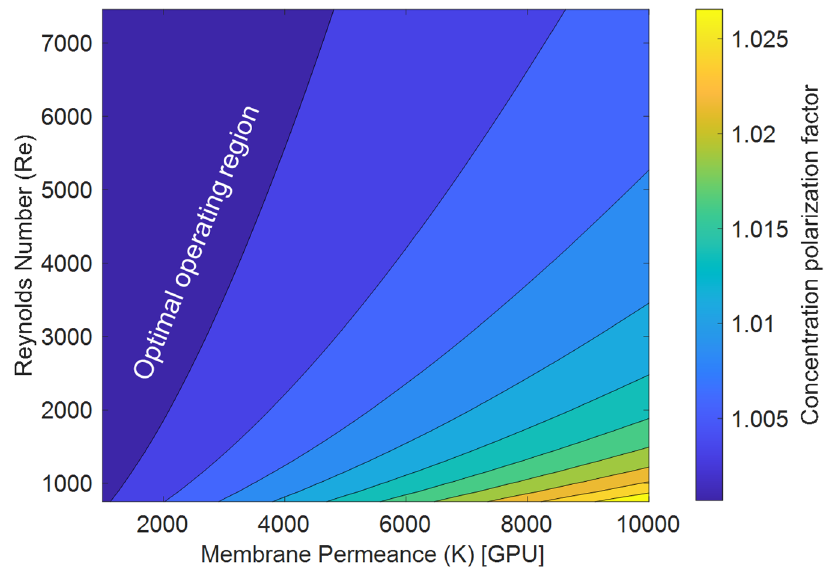
Figure 5. Effect of Reynolds number and membrane permeance on concentration polarization, calculated by the ratio of air concentration at membrane surface to the air concentration in the bulk of the channel. Operating the membrane energy exchanger in the turbulent regime helps avoid concentration polarization (top left region). T in = 27 ℃ , RH in = 70%, T coil = 10 ℃ , d = 3 mm with L × H × W as 0.8 m × 0.006 m × 0.3 m, N coils = 8, h cs = 0.006 m and L cs = 0.08 m.